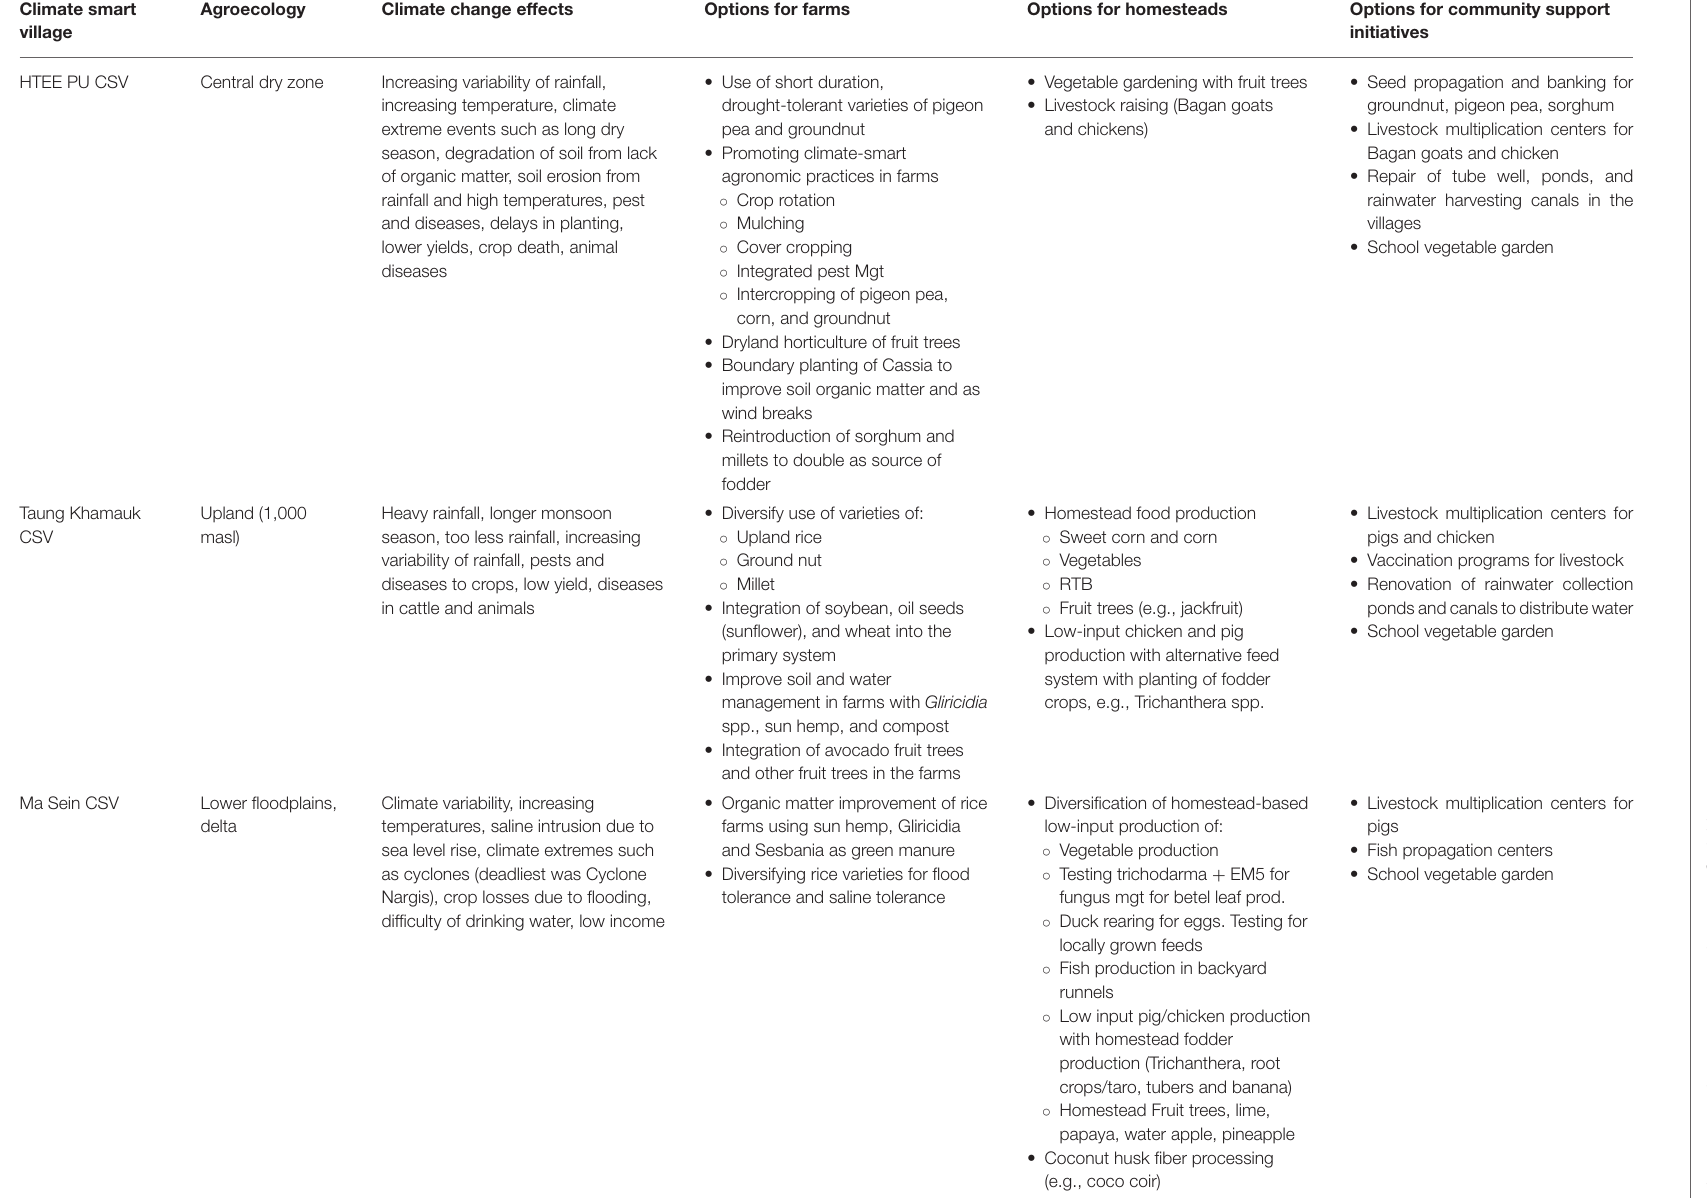
TABLE 5 | List of climate change adaptation options for the farms, homesteads, and community